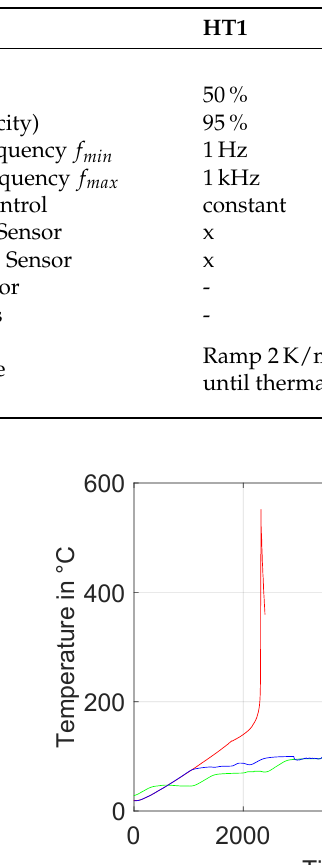
Figure 5. Left ( a ): Used HEL BTC500 type adiabatic calorimeter. Right ( b ): Schematic depiction of cell assembly inside of the calorimeter. Temperature and strain gauge sensors not shown. Table 1. Performed experiments and used instrumentation (marked with ‘x’).